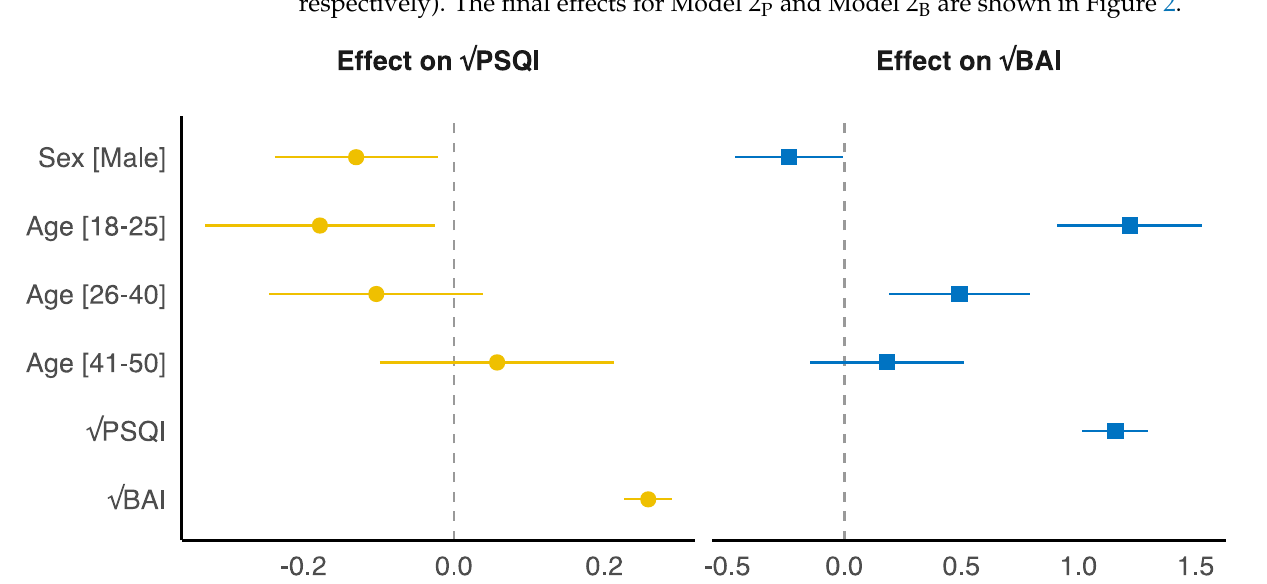
Figure 2. Model 2 P ( left ) and Model 2 B ( right ) explain significant and substantial proportions of the variance (R 2 = 0.39, F (5, 611) = 78.92, p < 0.001, adjusted R 2 = 0.39).